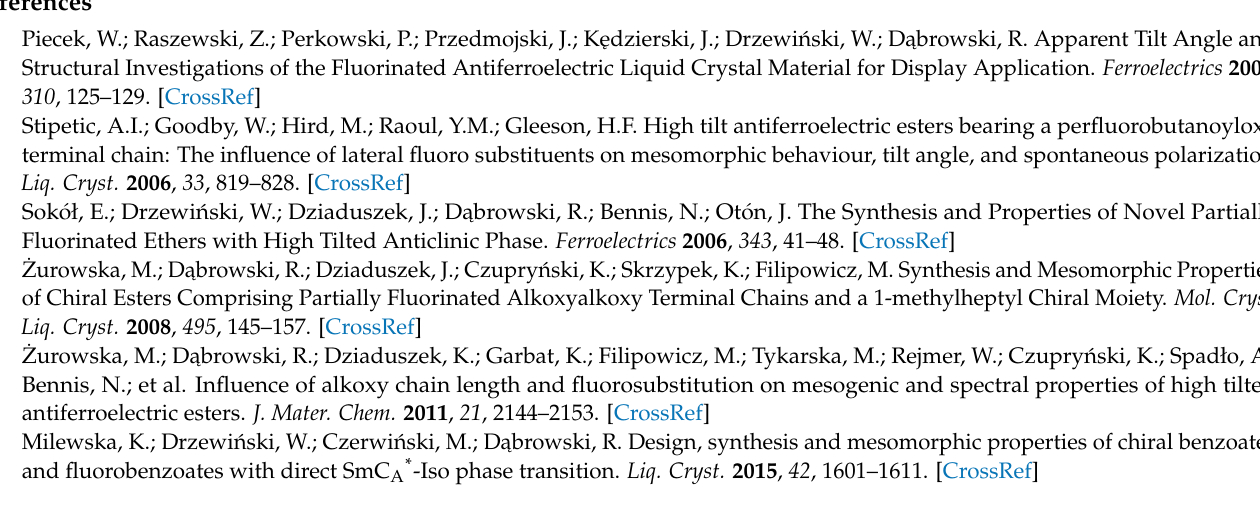
Figure S2: Textures of 3F7FPhH6 registered during heating from 173 K with 2 K/min rate analyzed with the fractal box count method, Figure S3: Textures of 3F7FPhH6 registered upon cooling with 2 K/min rate with histograms of luminance of red, green and blue components, Figure S4: Dielectric spectra of 3F7FPhH6 registered upon cooling without the bias field, Figure S5: Dielectric spectra of registered upon cooling in the 40 V bias